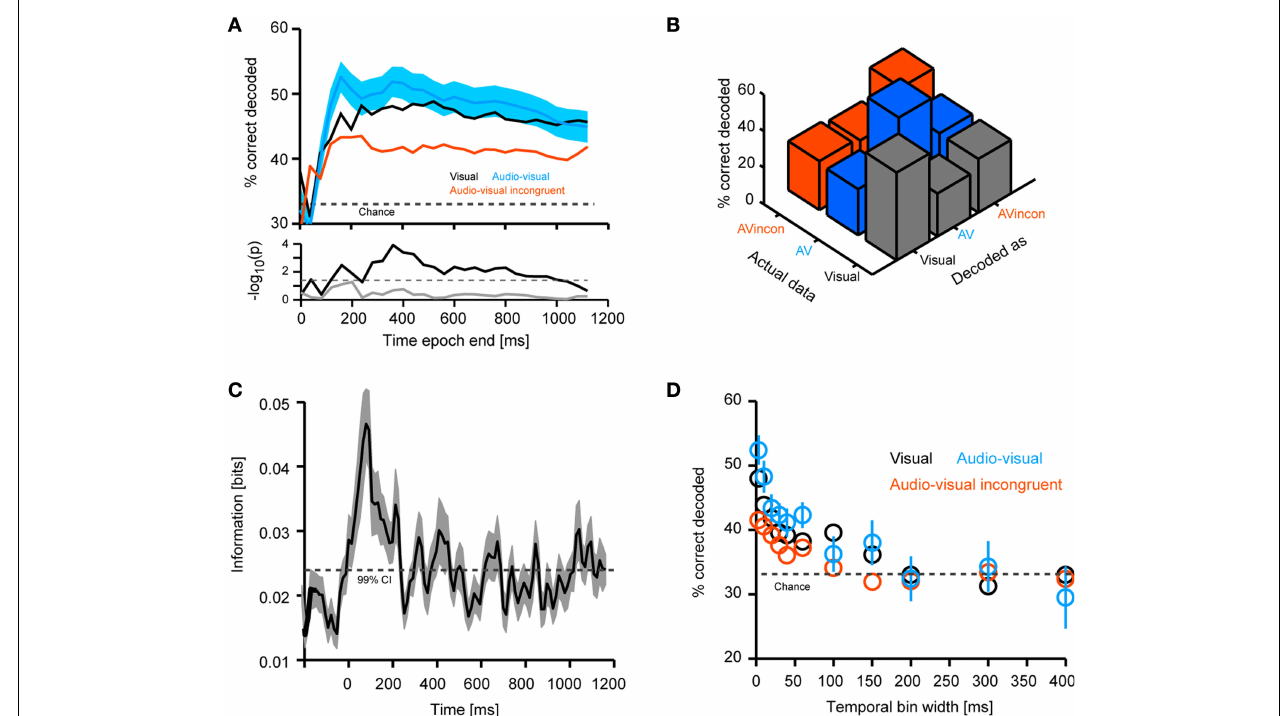
FIGURE 3 | Decoding of different stimulus modality combinations. (A) Performance in decoding the different stimulus conditions (visual, congruent and incongruent audio-visual). For decoding the full time course of the response sampled at 20 ms was considered. The graphs display decoding performance as a function of the response interval considered, which started at stimulus onset and terminated at the corresponding value on the x -axis. Lines denote the mean across units ( n = 61), blue area indicates the standard error for the congruent condition. Chance level is 33%. The lower panel displays the p -values (on a negative logarithmic axis) of point-wise t -tests between congruent and incongruent bimodal conditions (black) and visual and congruent bimodal conditions (gray). The dashed line indicates a critical p -value of 0.05 corrected